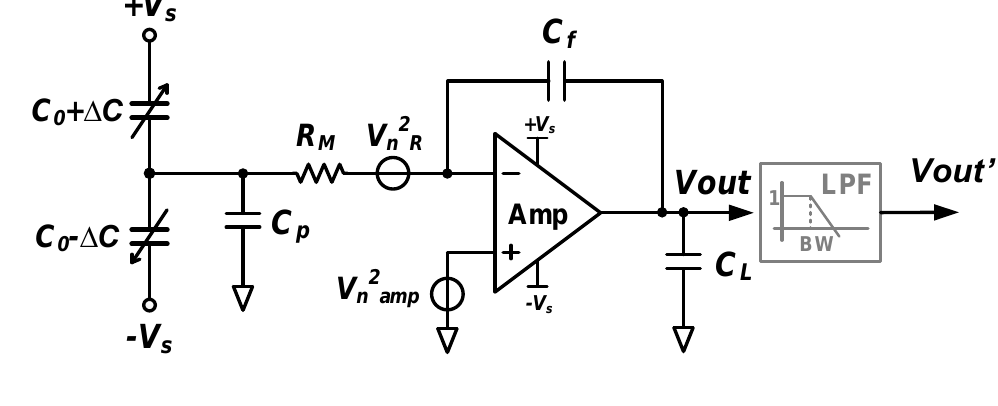
Figure 9. The single-ended simplified schematic for noise analysis of conventional SC